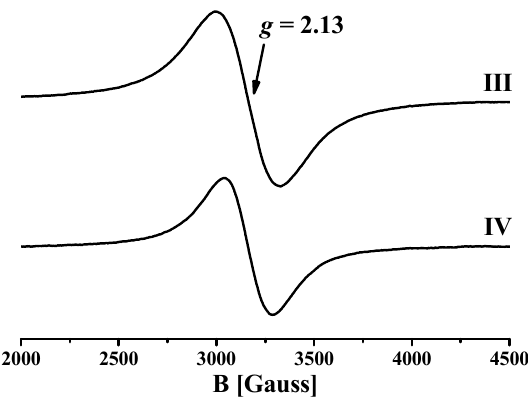
Figure 7. Room temperature X-band EPR spectra from powdered samples of III and IV .